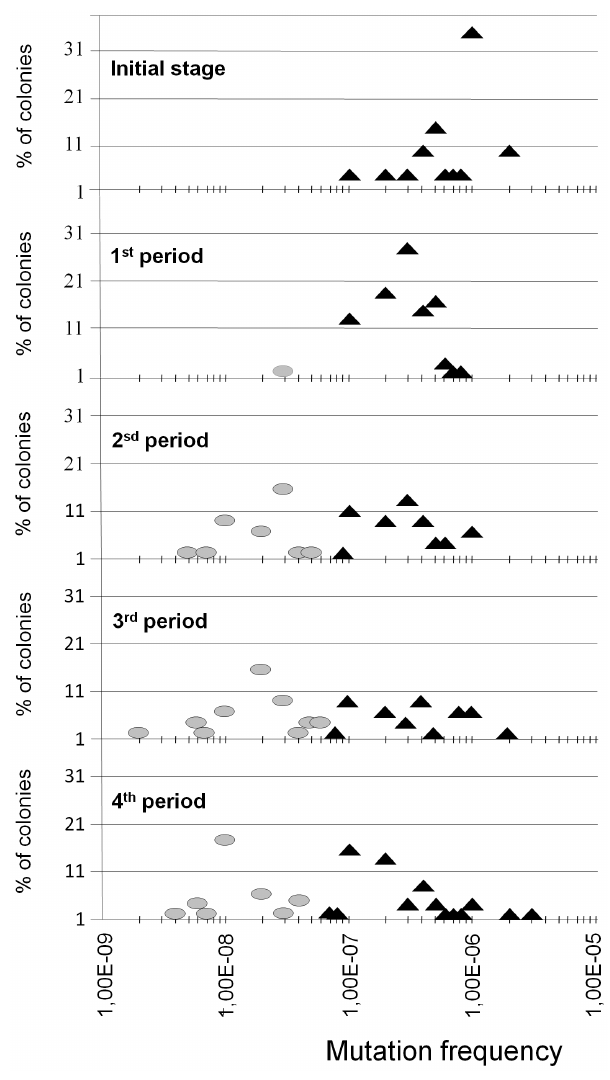
Figure 3. Distribution of the proportion of colonies with high and low mutation frequencies along four successive periods. On the top, distribution of f values in 20 colonies of the ancestor strain; below, distributions of f values in 45–51 colonies from 15 different passages belonging to each one of the 1 st (from 13 th to 53 rd passage), 2 nd (from 58 th to 93 rd passage), 3 rd (from 97 th to 138 th passage) and 4 th (from 141 st to 180 th passage) periods respectively. Black triangles and grey circles correspond to colonies with high- or low frequencies of mutation respectively. the 2 nd , and 3 rd periods, evolving back to the lower level of the ancestral strain (0.96) in the 4 th period. Normo-mutable derived colonies had mean fitness values of s = 1.69 and 1.60 at the 3 rd , and 4 th periods respectively, higher than most of evolved mutator colonies (see Figure S4). However, a fraction of evolved mutator colonies retained a high fitness, explaining the coexistence with evolved normo-mutators at the end of the experiment.